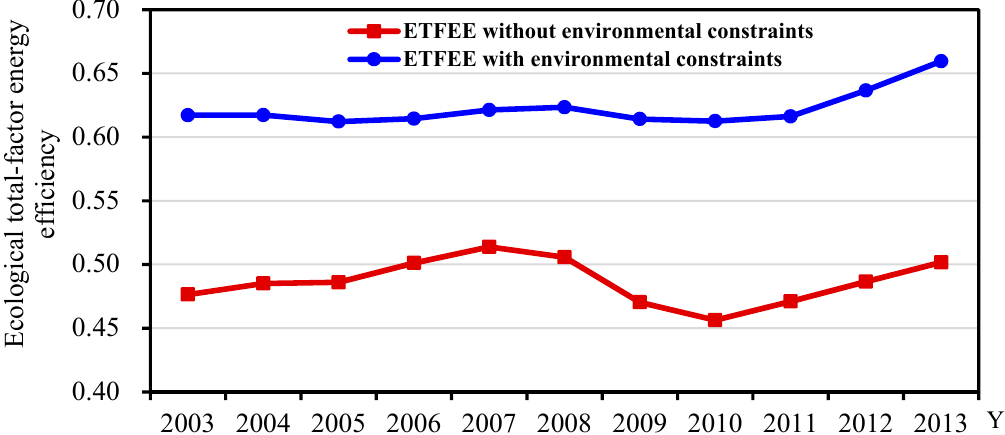
Figure1. Ecologicaltotal-factorenergye ffi Figure 1. Ecological total-factor energy efficiency variations with and without environmental constraints.